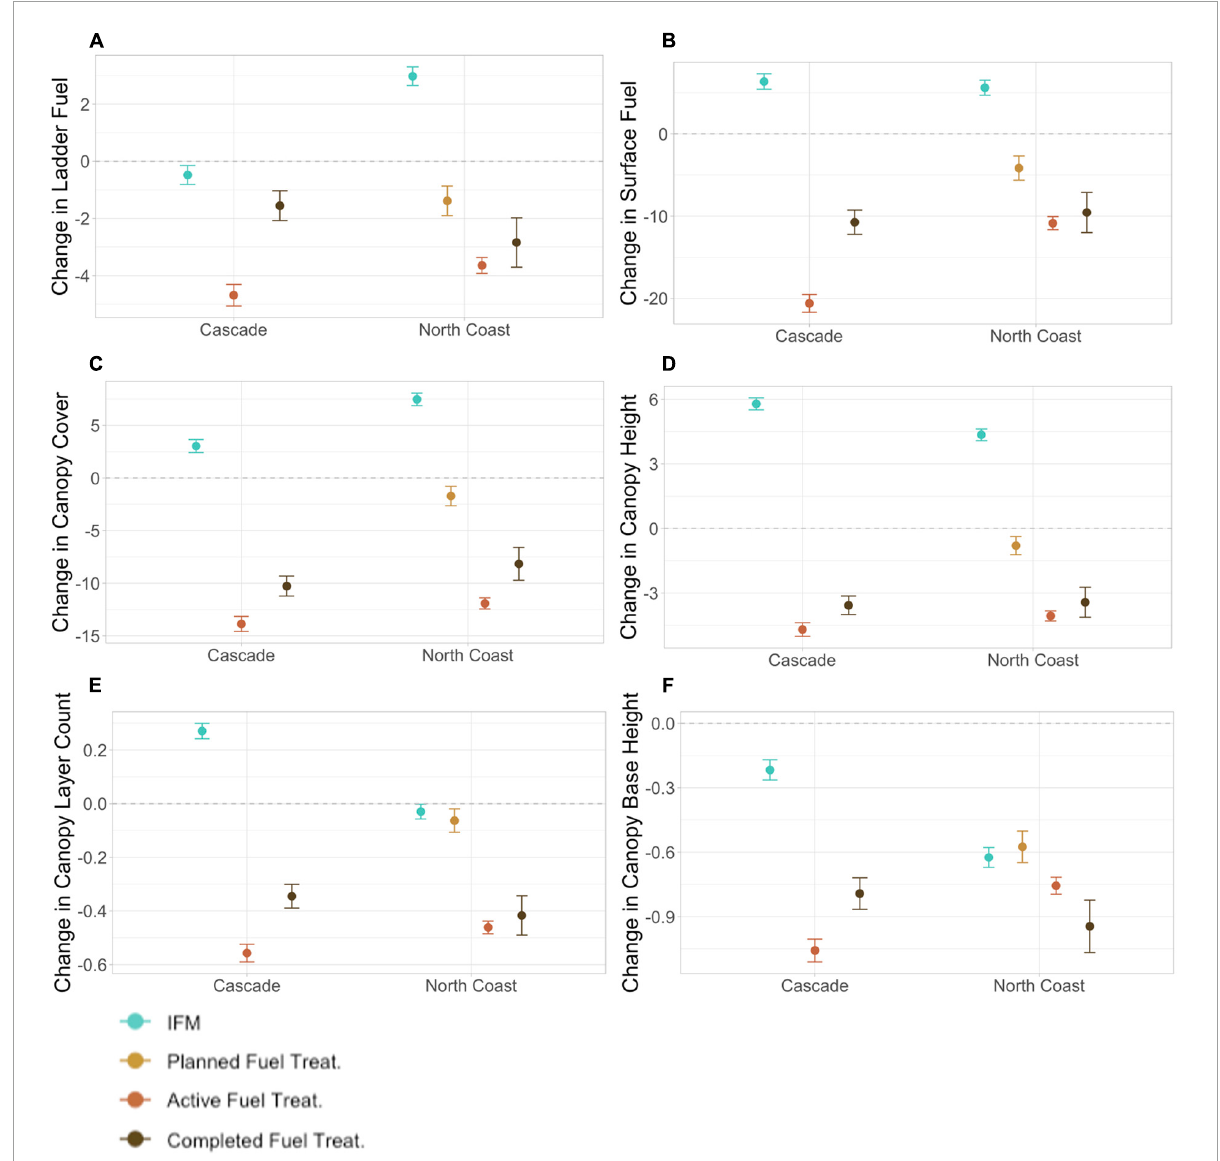
FIGURE3 Estimated change between 2016 to 2020 for (A) ladder fuel, (B) surface fuel, (C) canopy cover, (D) canopy height, (E) canopy layer count, (F) canopy base height between offsets and fuel treatments completed prior to 2016. These graphs should the predicted change from the matched regression using the 2016 variable (A–F) , respectively, for each